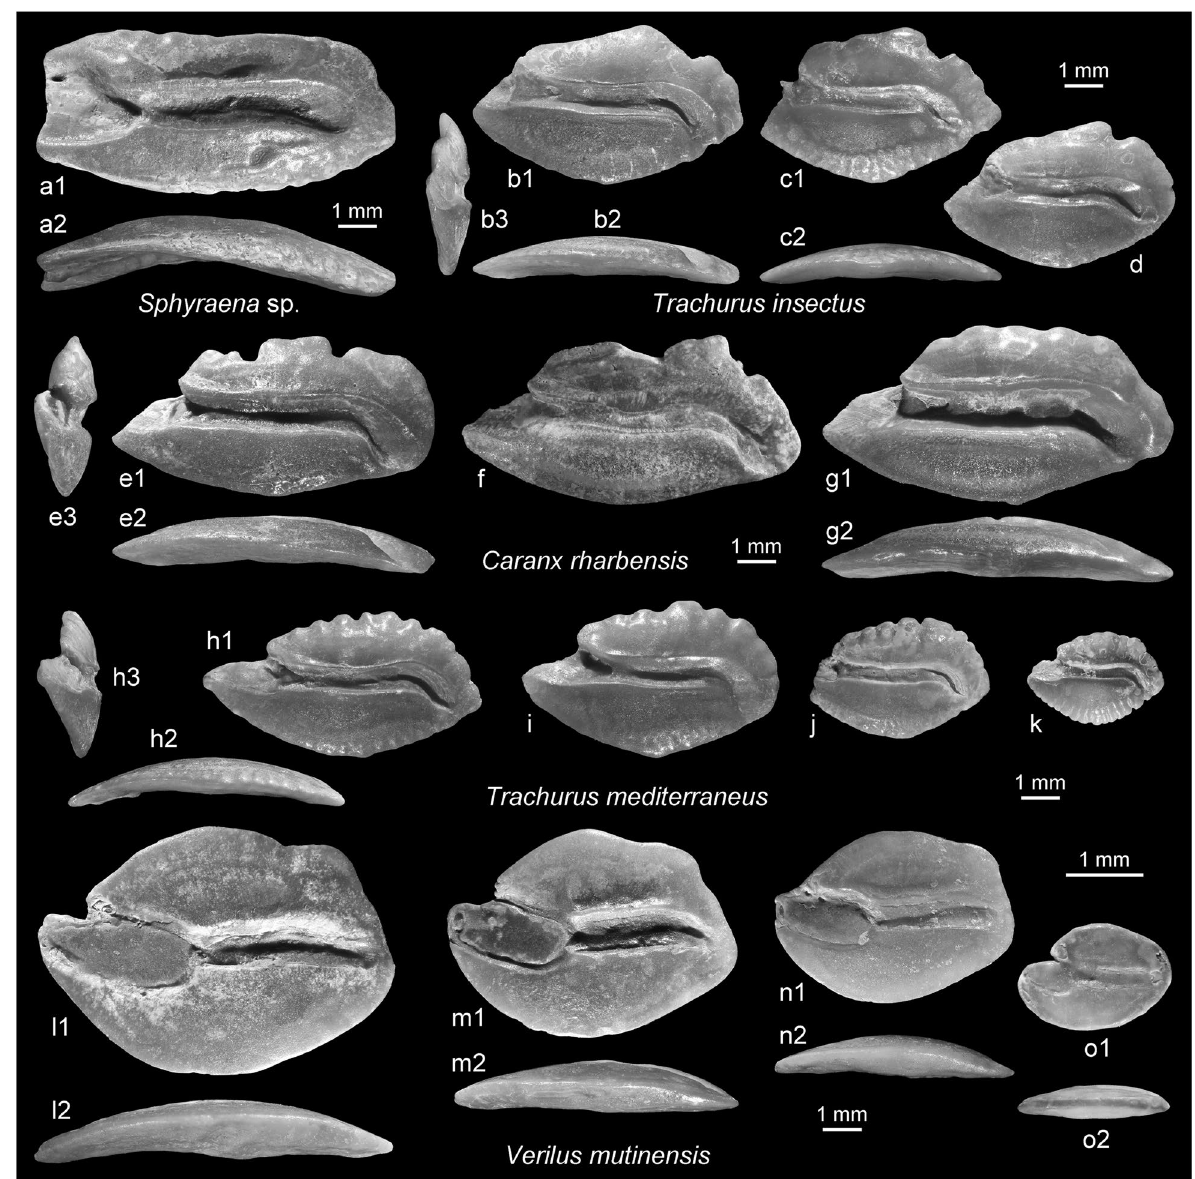
Fig. 22 Sphyraenidae, Carangidae and Acropomatidae. a Sphyraena sp., SMF PO 101.237, Dar bel Hamri. b – d Trachurus insectus n. sp., Dar bel